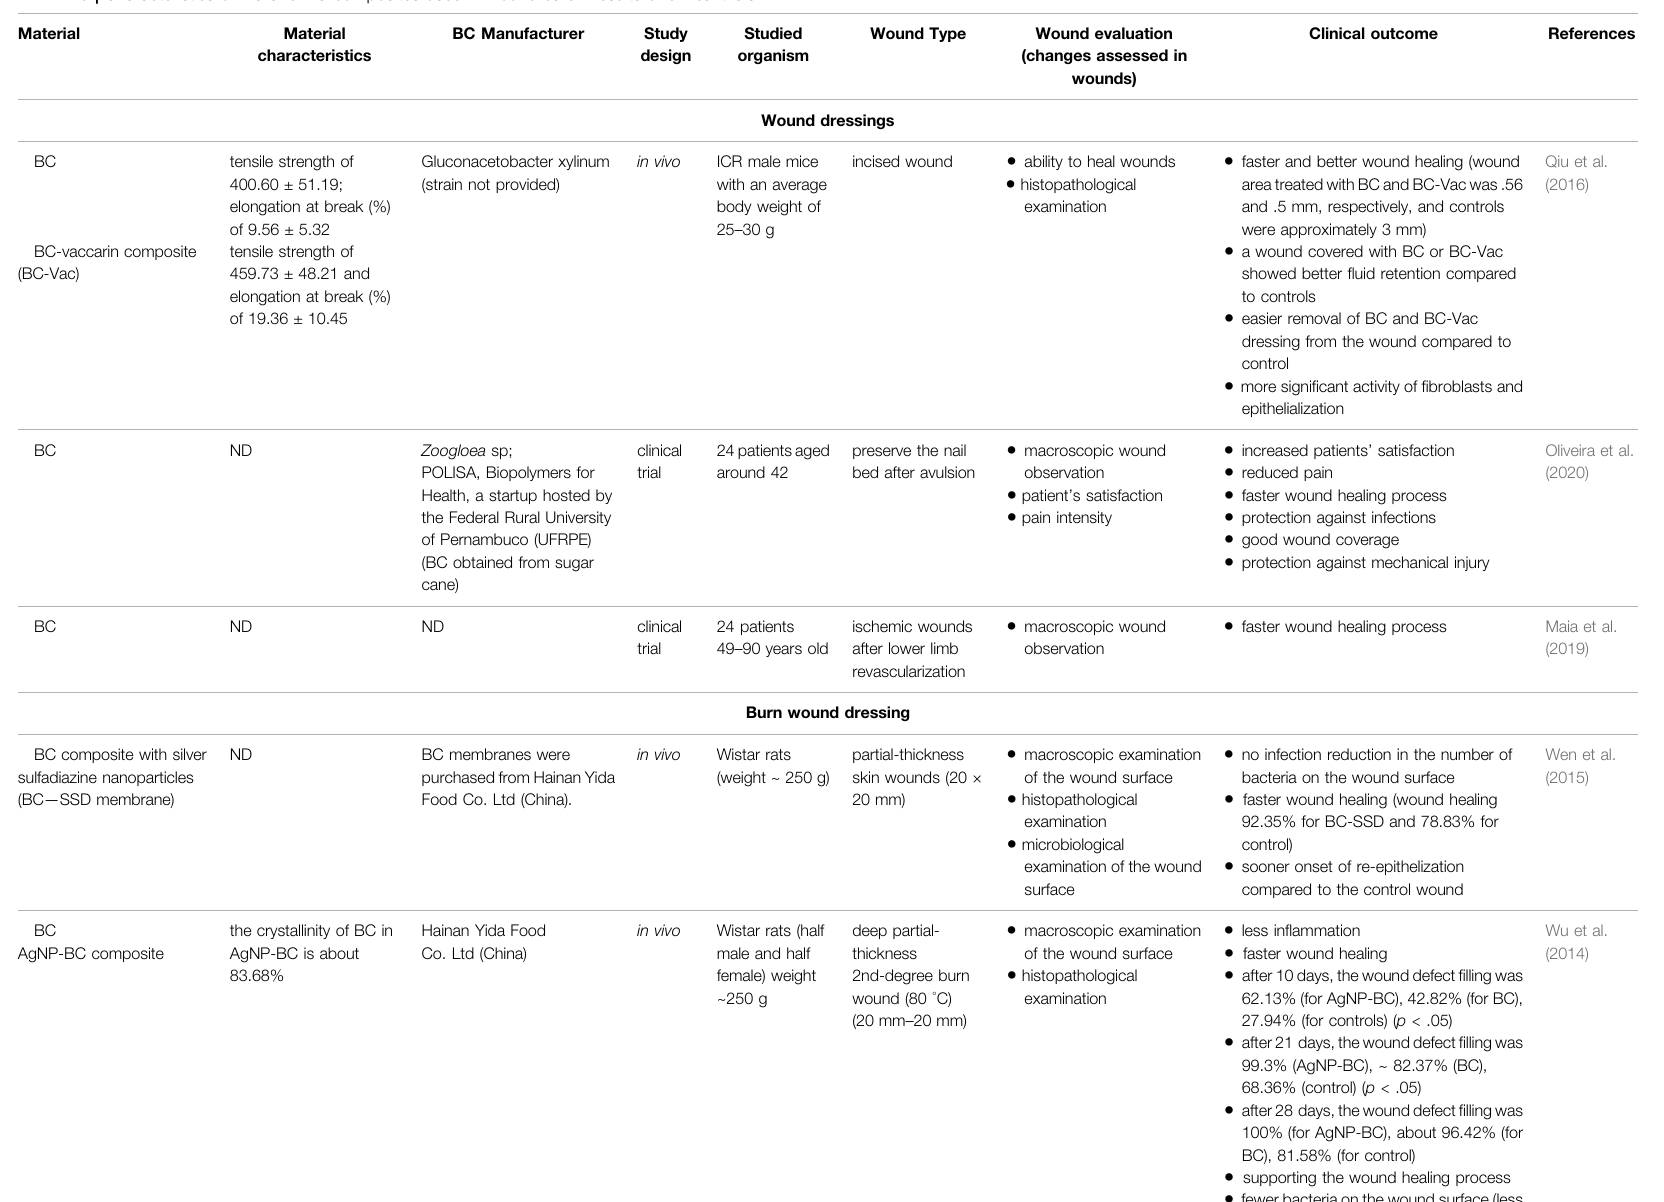
TABLE 3 | Characteristics of BC and BC composites used in wound care — results of clinical